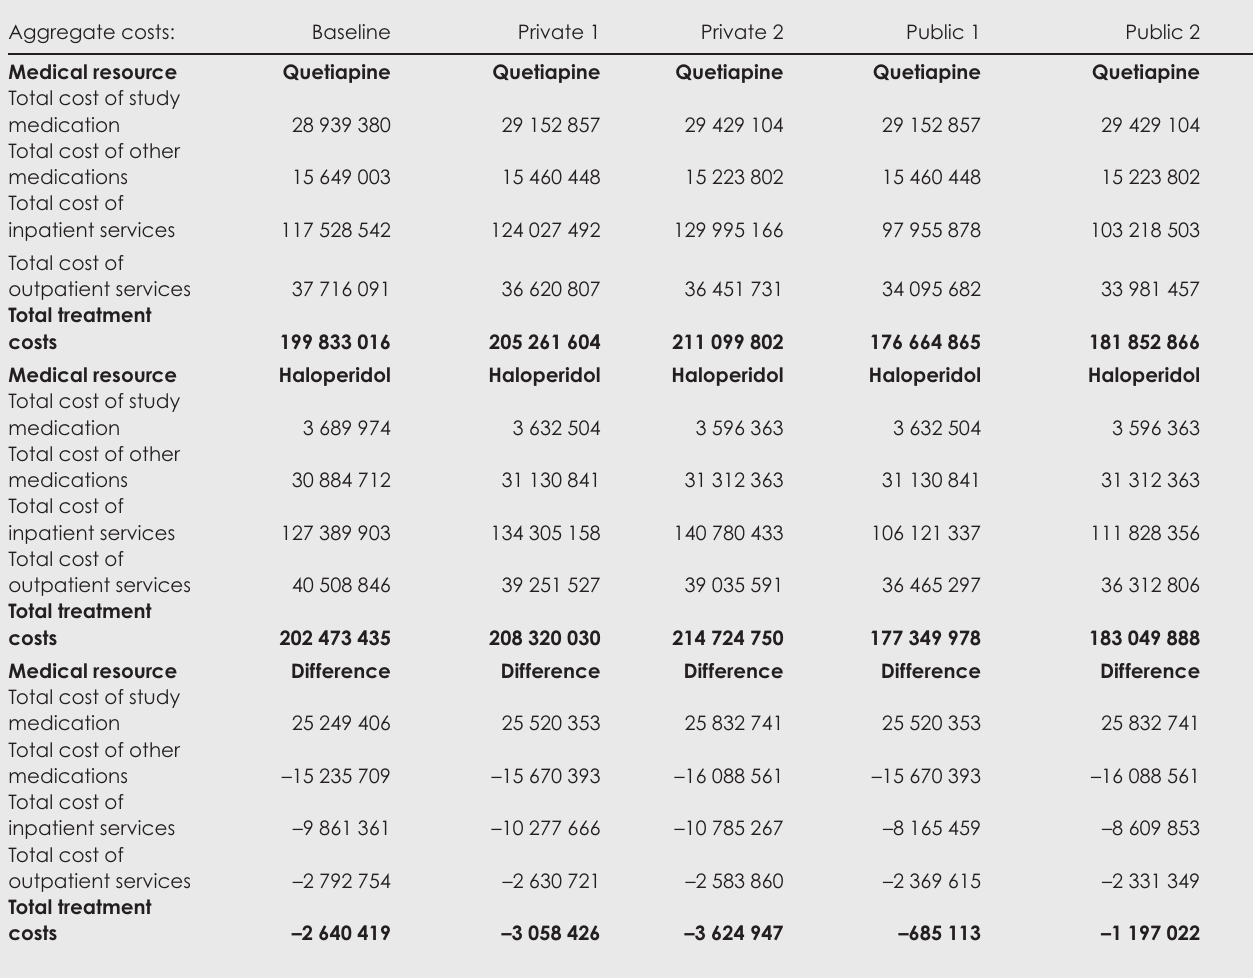
Table IV. Estimated total costs of different health care situations for South Africa